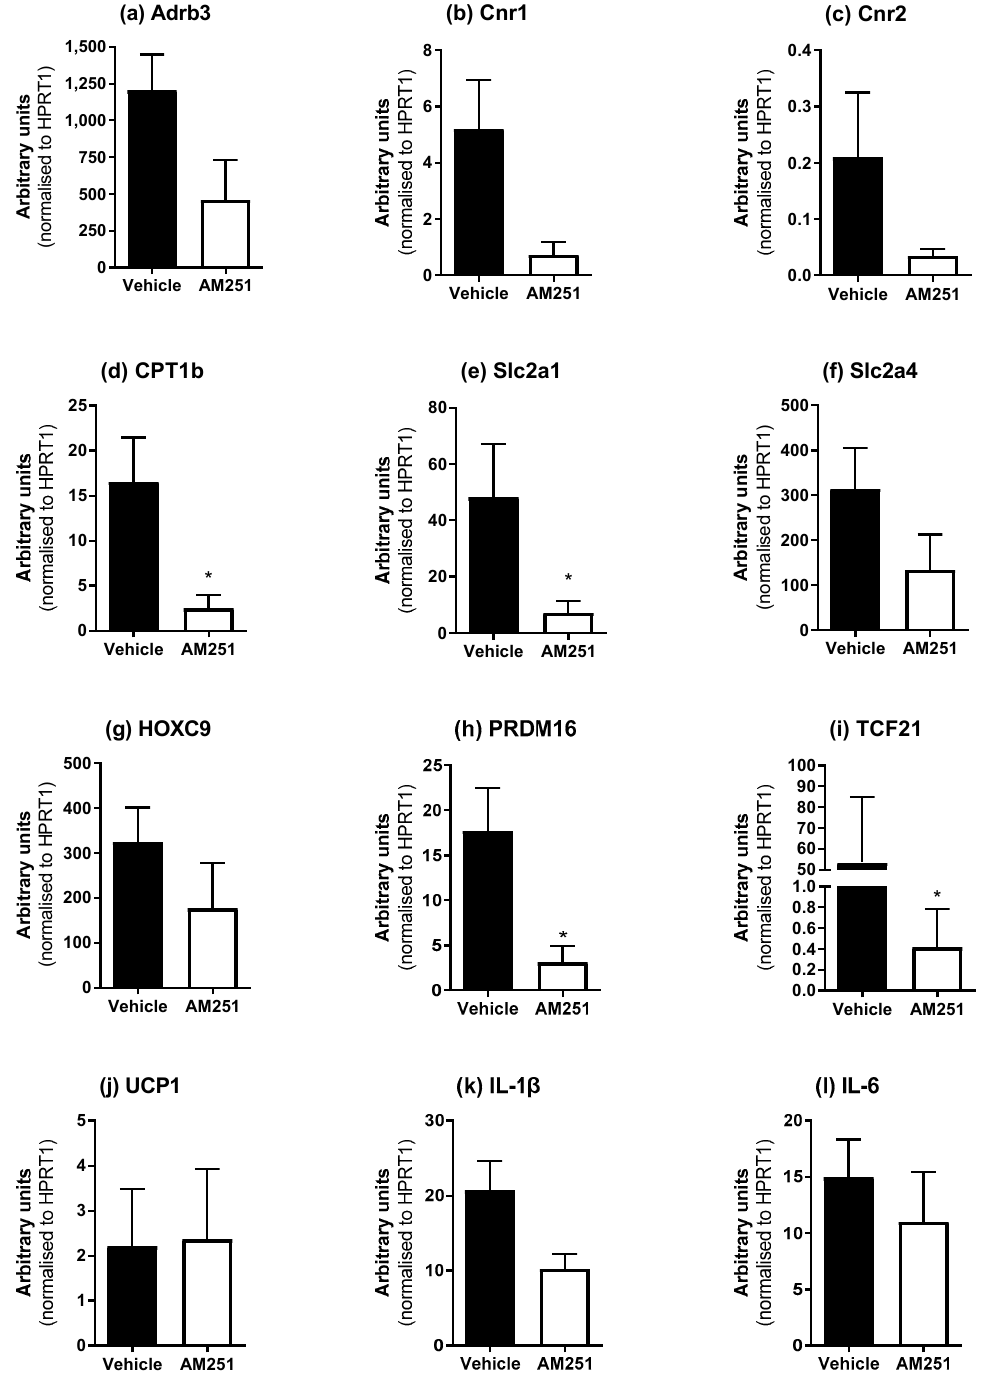
Figure 4. Effect of AM251 treatment in HFD rats on peri-renal WAT mRNA expression. HFD rats were injected daily with either AM251 (3 mg/kg of body weight, ip) or vehicle for six weeks. All results are presented as a mean ± SEM in arbitrary units (normalized to housekeeping gene HPRT1) from n = 4 (AM251) and n = 8–10 (vehicle) treated rats on an HFD. Significance * p ≤ 0.05 compared to